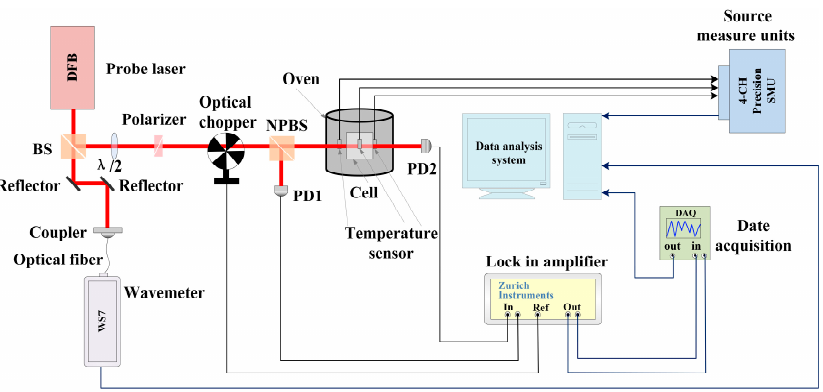
Figure 6. Schematic of the Rb vapor-density measurement system.